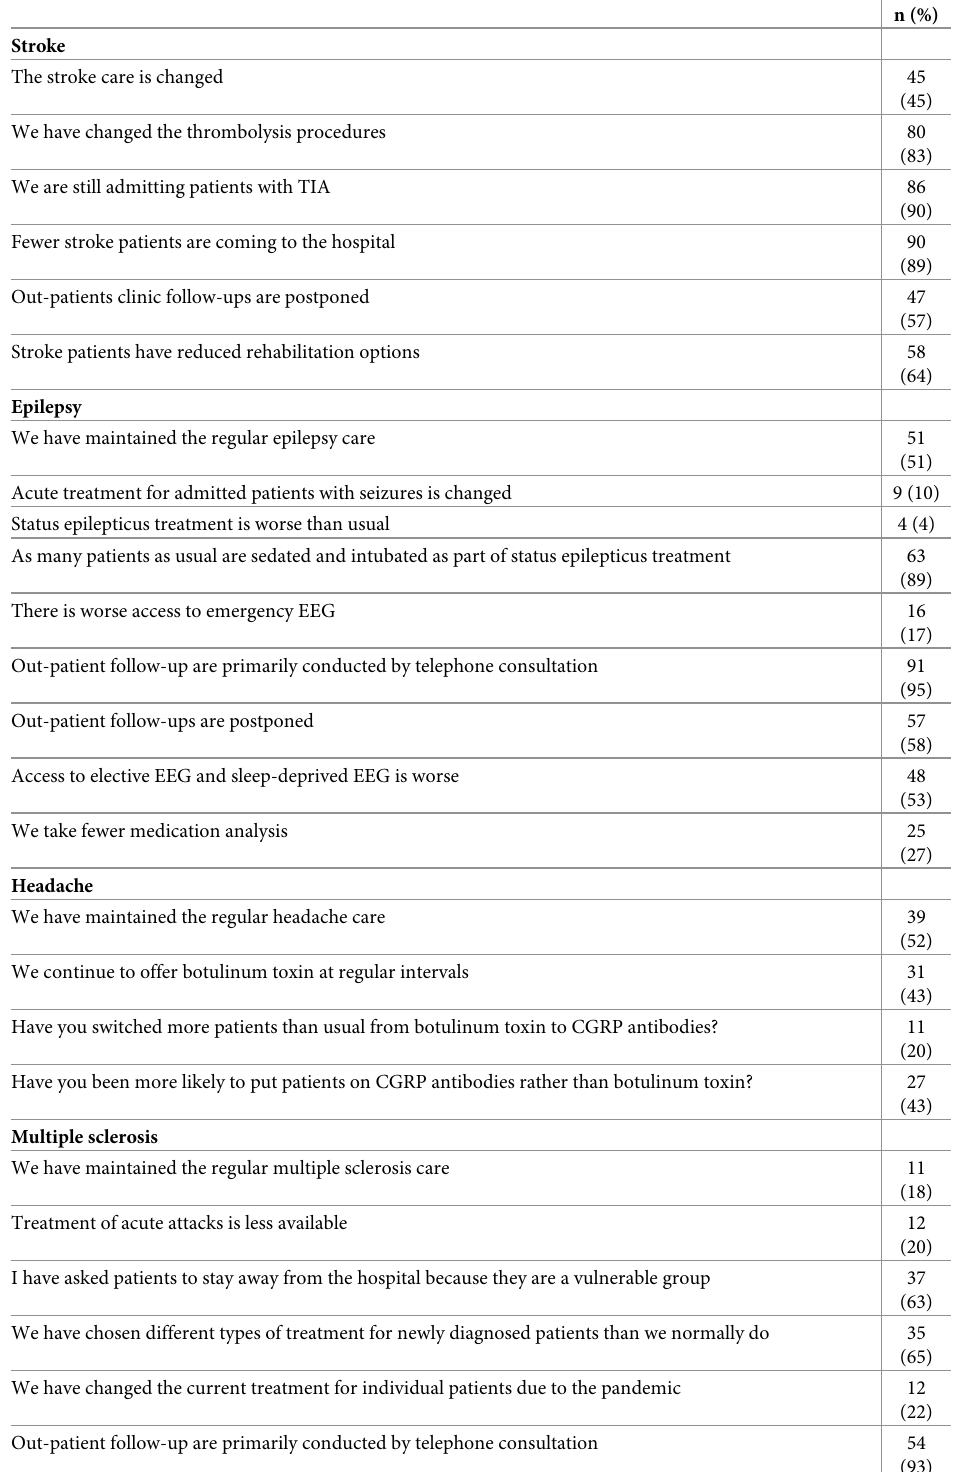
Table 4. Management of ten different neurological disorders during the initial phase of the COVID-19 pandemic, n